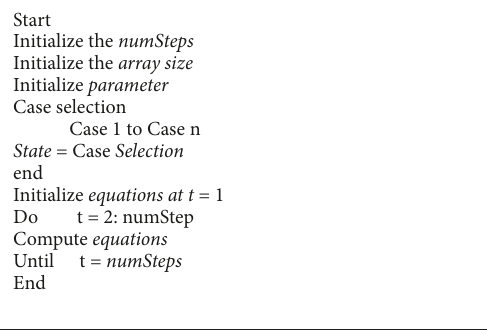
Figure 5: Te model simulation Table 2: Values of uninspiring case condition.